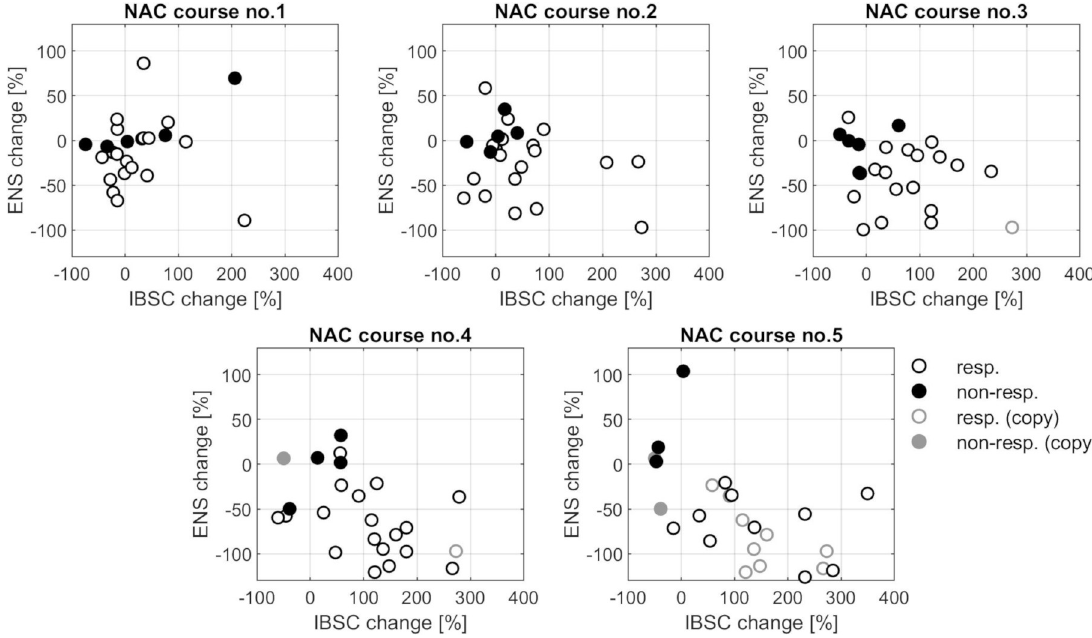
Fig 5. Scatter plots of pairs of features, ENS vs. IBSC, for all PR and N-PR tumors for each treatment stage. Some patients have undergone less than five NAC courses; in these cases, the results obtained after their last NAC course were copied into the further results (less intense